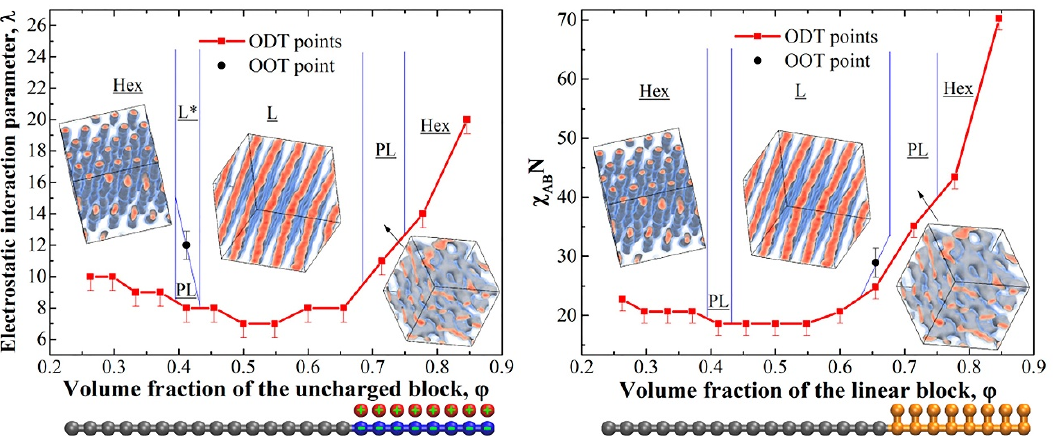
Figure 2. Phase diagrams of diblock-copolymers with one charged block ( left ) and uncharged diblock-copolymers for the main (linear) chain length of N = 24 ( right ). Reproduced from reference [119].